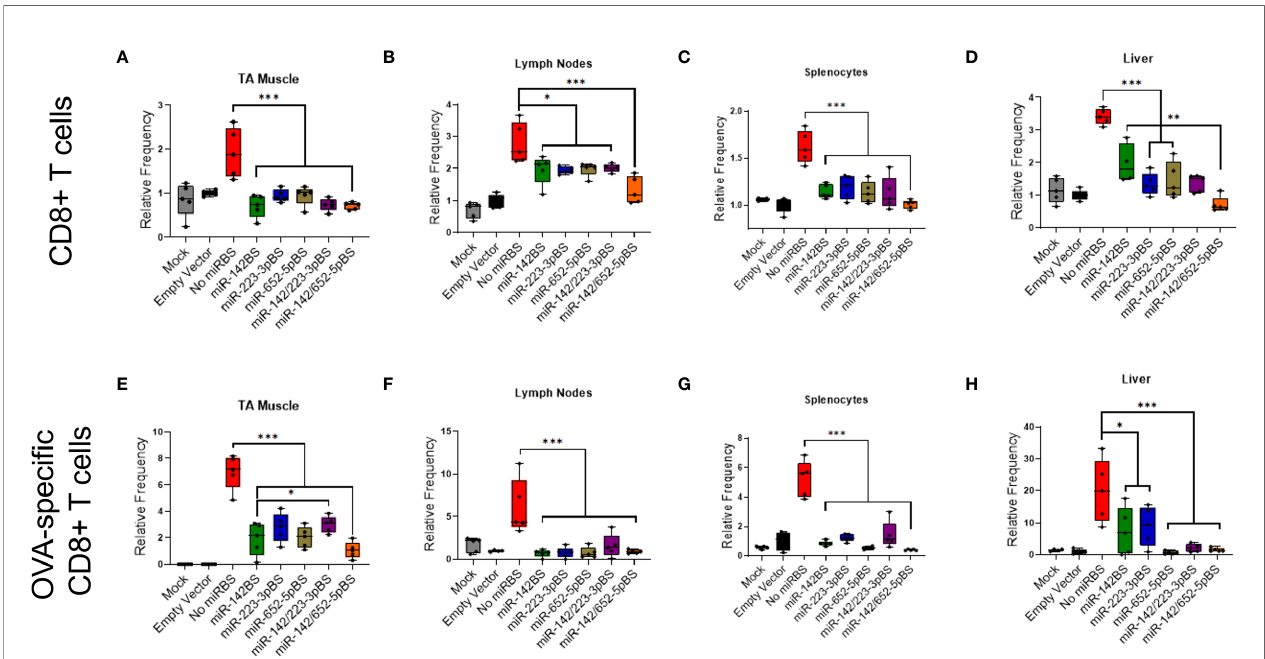
FIGURE 4 | miR-142BS-, miR-223BS-, and miR-652-mediated detargeting suppresses OVA speci fi c CD8 T cell response. C57BL/6 male mice, six weeks old, were i.m. injected with mock, empty capsid, or rAAV1. OVA vectors with or without miR-BSs (1 × 10 11 GCs/mouse). Mice were sacri fi ced four weeks after treatment and cells were isolated from TAs, lymph nodes, spleens and livers. Cells were then stained for CD8 T cell markers or with anti-CD8a/H-2Kb SIINFEKL tetramer and quanti fi ed by fl ow cytometry ( n = 5). Relative frequencies of CD8+ T cells (A – D) and OVA-speci fi c CD8+ T cells (E – H) are depicted as box plots with means, fi rst and third quartile boundaries, and whiskers indicating max and min values ( n = 5). p values were estimated by one-way ANOVA with Tukey ’ s post hoc test. * p < 0.05, ** p < 0.01, *** p <